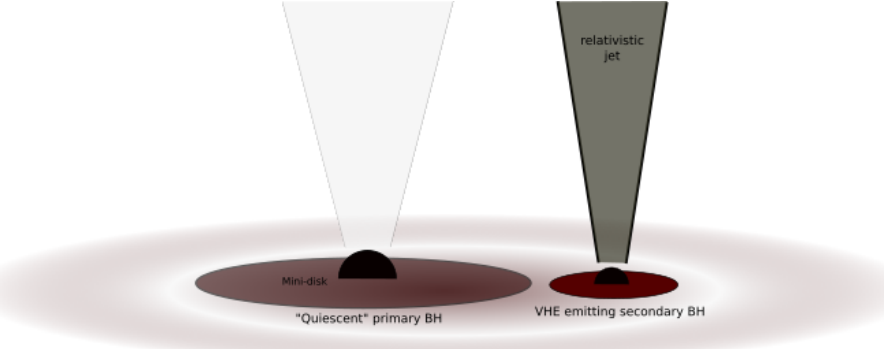
Figure 11. A possible binary black hole model for PKS 2155-304, with the binary (black holes plus mini-disks) being surrounded by a circumbinary disk. The tidal gas stream from this disk preferentially feeds the less massive, secondary black hole, whose jet emission dominates the observed VHE radiation spectrum. Both the short VHE variability and the high (apparent) luminosity can thus be accommodated, cf.